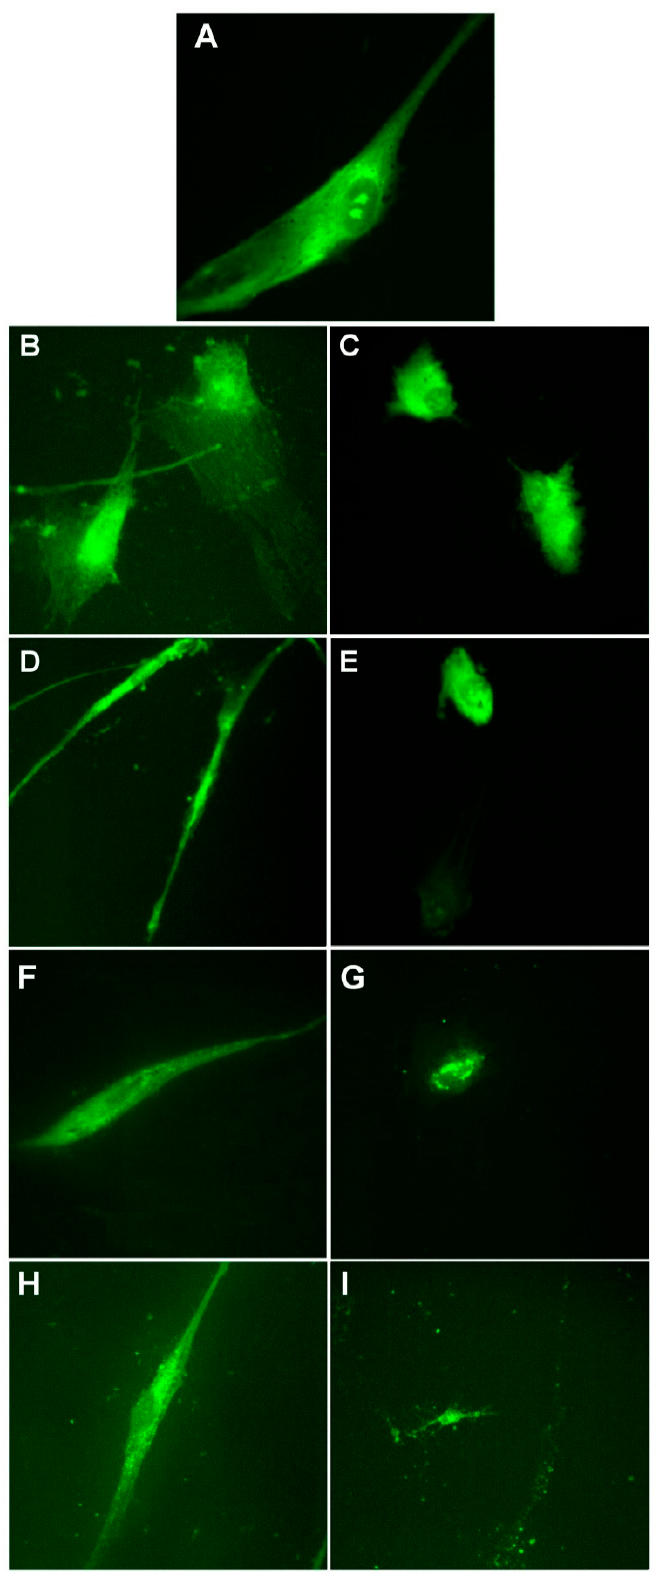
Figure 13. Morphology of control BJ cells ( A ) and cells after treatment with 6.4 µM and 51.1 µM of P3 ( B , C ), P4 ( D , E ), P5 ( F , G ), and P6 ( H , I ). Images are obtained with a 40× objective and using the epifluorescence mode.